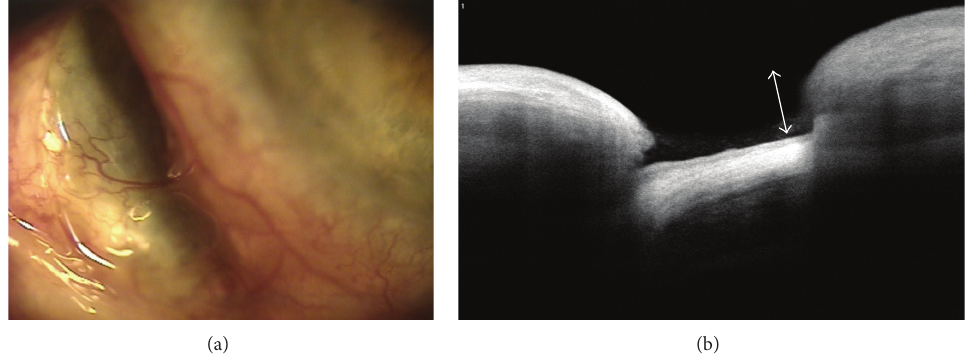
Figure 4: Anterior segment photography (a) and OCT image (b) of scleral thinning after